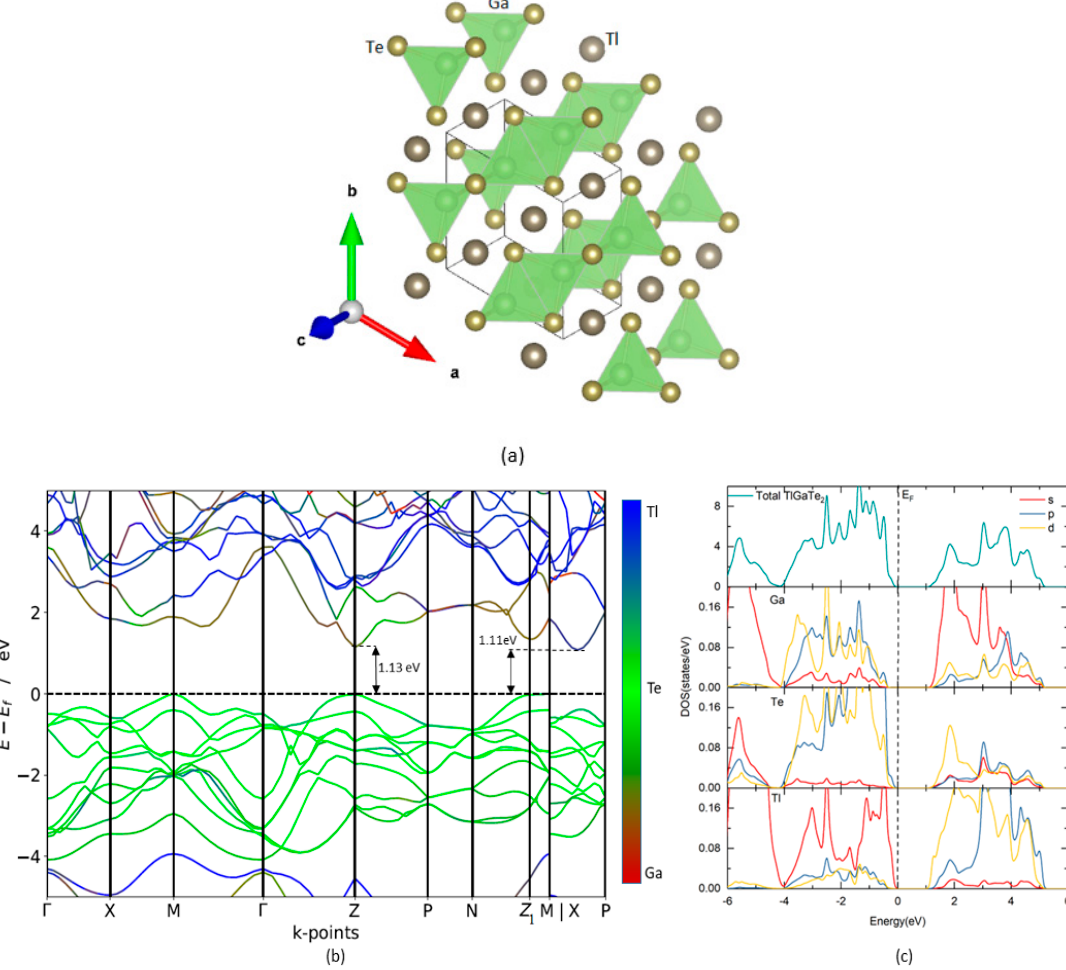
Figure 1. ( a ) Crystal structures of TlGaTe 2 . The illustration shows the legends for the different type of atoms; ( b ) calculated HSE06 electronic band structure of TlGaTe 2 ; ( c ) total and site projected density of states of TlGaTe 2 . The Fermi level is set to zero. (colour code: red-Ga, green-Te, blue-Tl). Table 1. The calculated effective masses of TlGaTe 2 , where m* hh and m* e are the effective masses of heavy holes and electrons respectively. m e is mass of the electron.